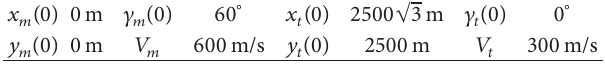
Table 1: The initial condition for the missile and target.